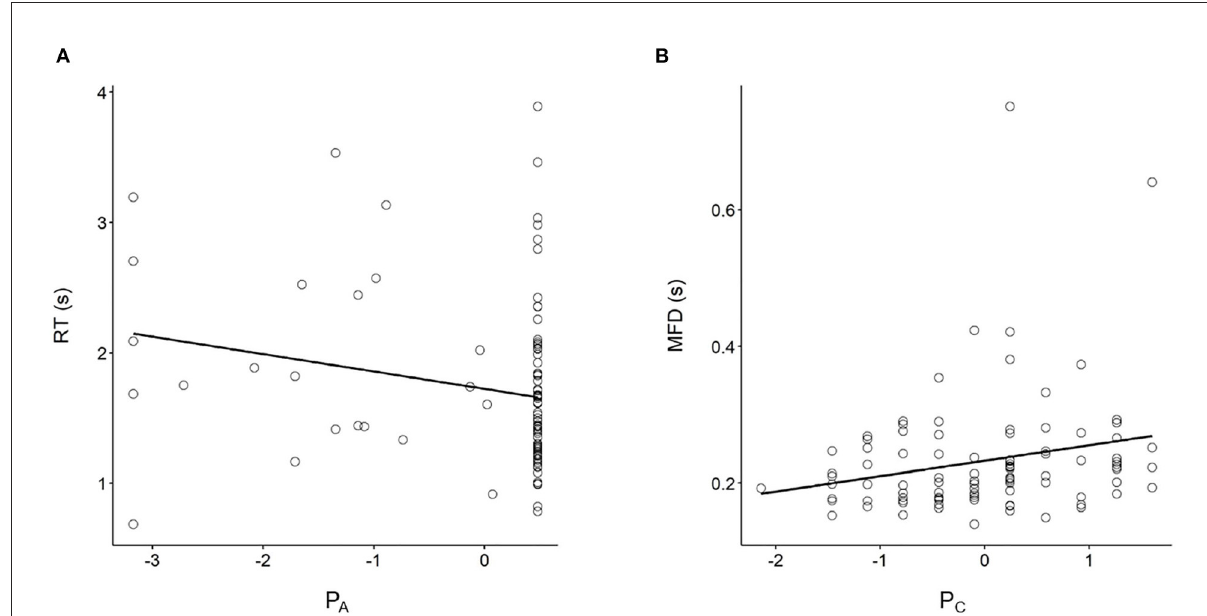
FIGURE2 Scatter plots of the PDP parameters and behavioral data. (A) RT correlated negatively with the P A parameter; (B) MFD correlated positively with the P C